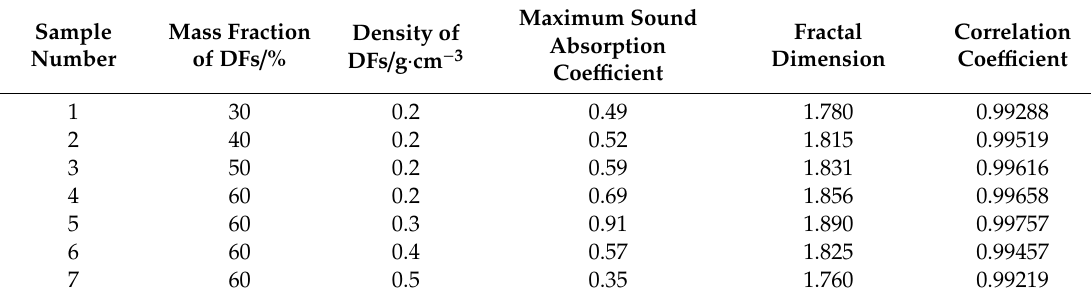
Table 3. Relevant parameters of samples.